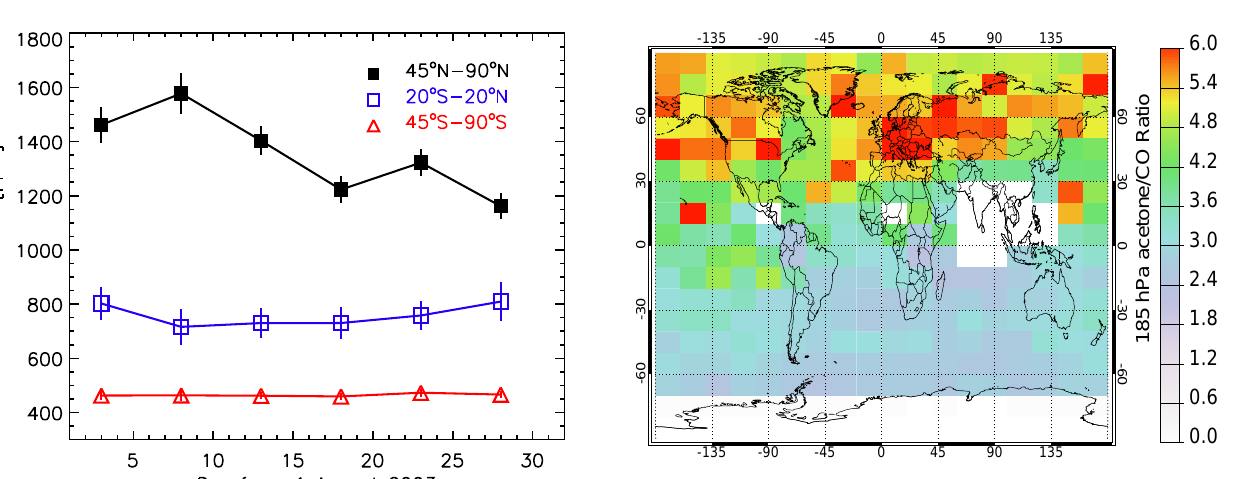
Fig. 12. Daily-average acetone volume mixing ratios for three re- gions at an average pressure level of 277 hPa; (a) 45 ◦ N to 90 ◦ N, (b) 20 ◦ S to 20 ◦ N and (c) 45 ◦ S to 90 ◦ S.